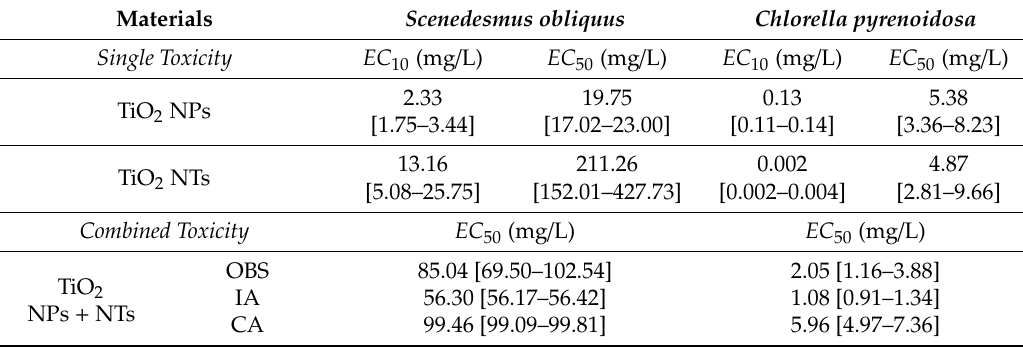
Figure 3. Concentration–response curves for Scenedesmus obliquus ( A ) and Chlorella pyrenoidosa ( B ) exposed to TiO 2 NPs, TiO 2 NTs, and TiO 2 NPs + NTs. Table 2. Effect concentrations derived from concentration–response curves of the single nanoparticles and the mixtures a .